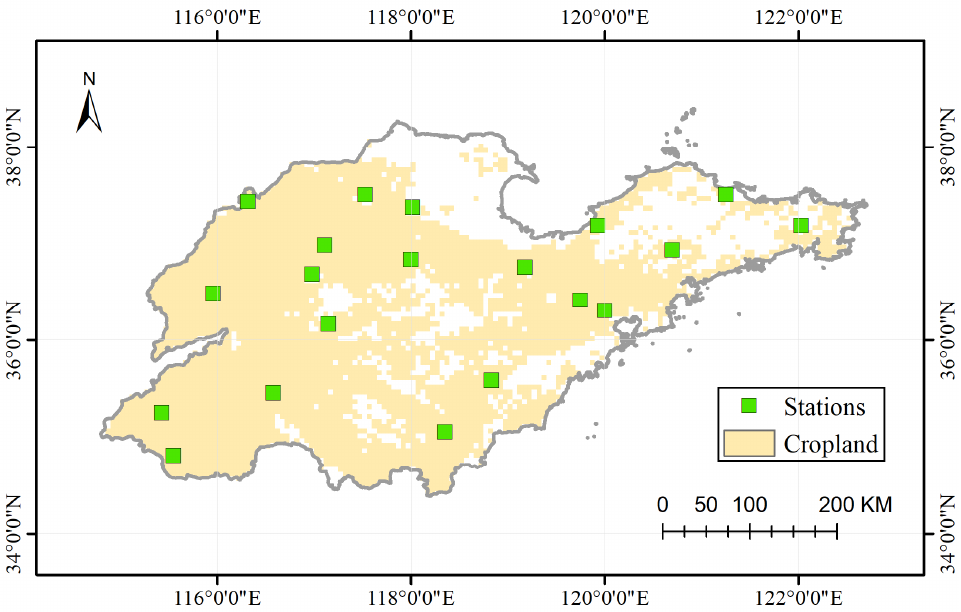
Figure 1. Cropland and phenological stations distribution in Shandong Province of China. The distribution of cropland is identified according to the International Geosphere-Biosphere Program global land cover classification system.